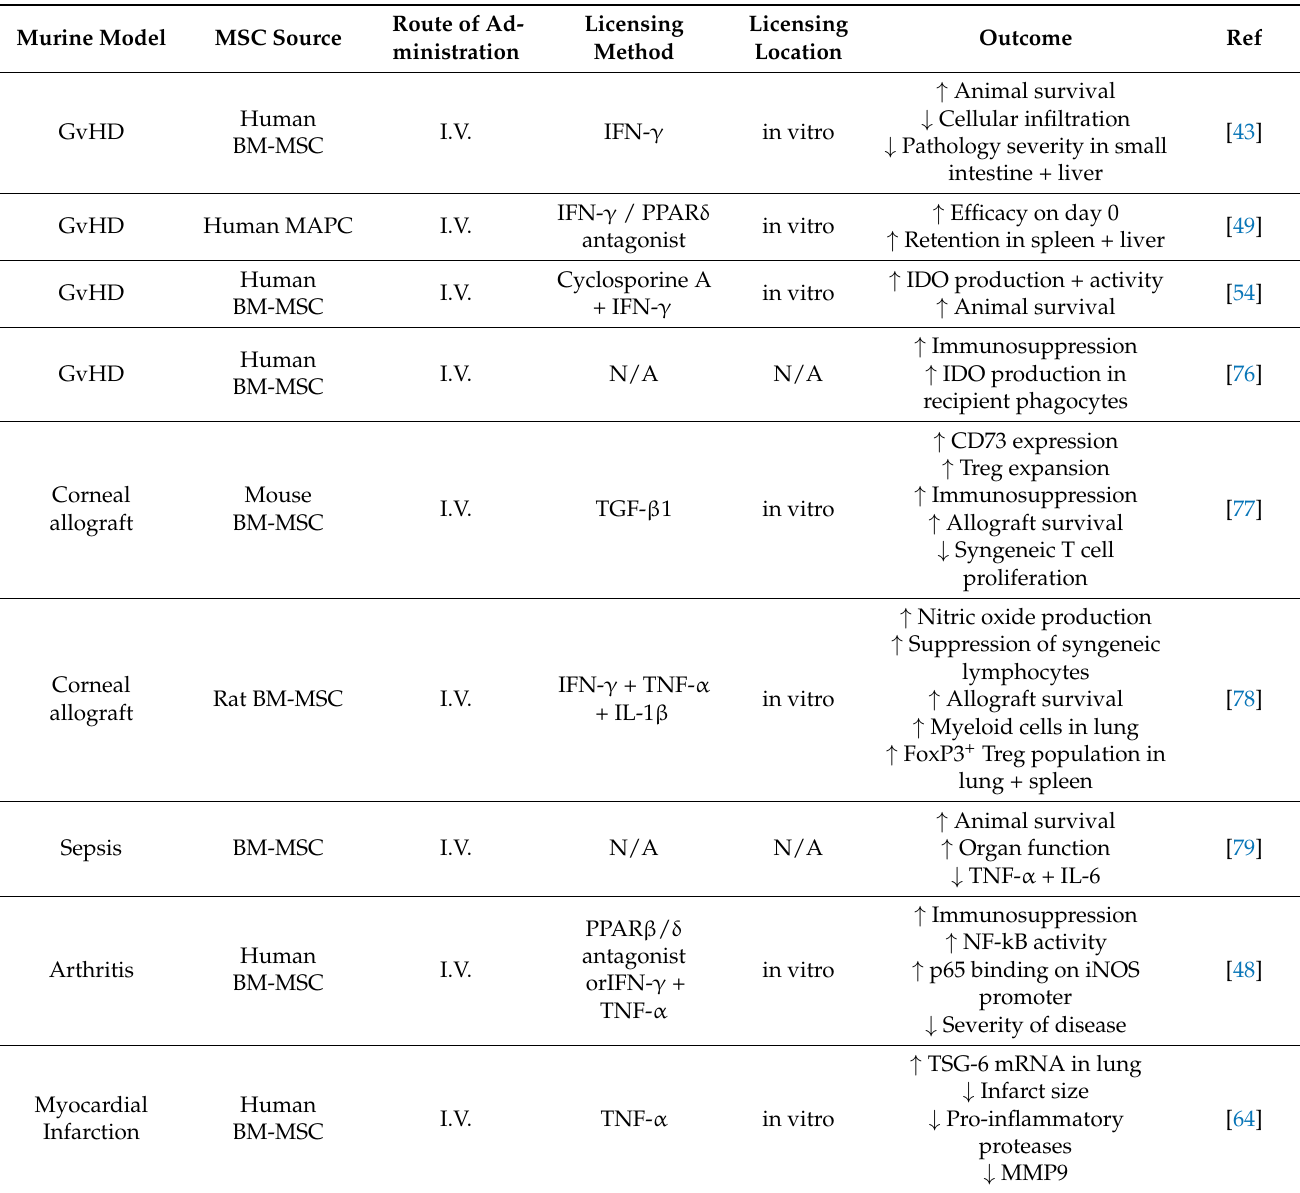
Table 2. In vivo studies utilising MSC